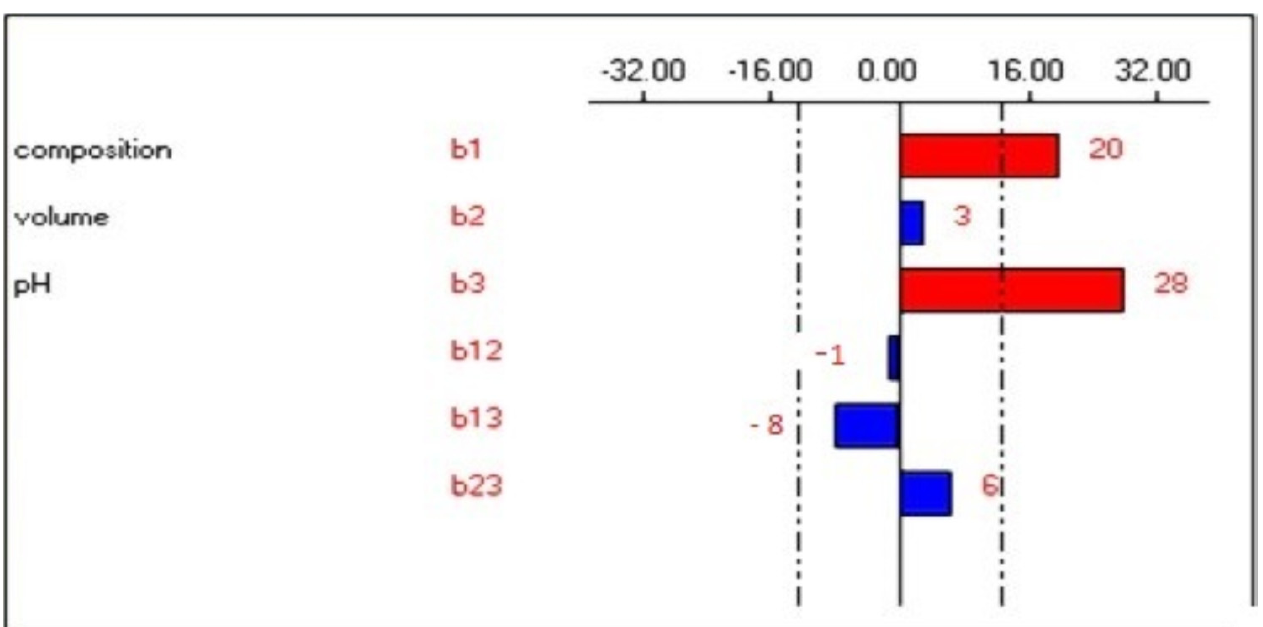
Figure 1. Pareto chart for the elution phase.